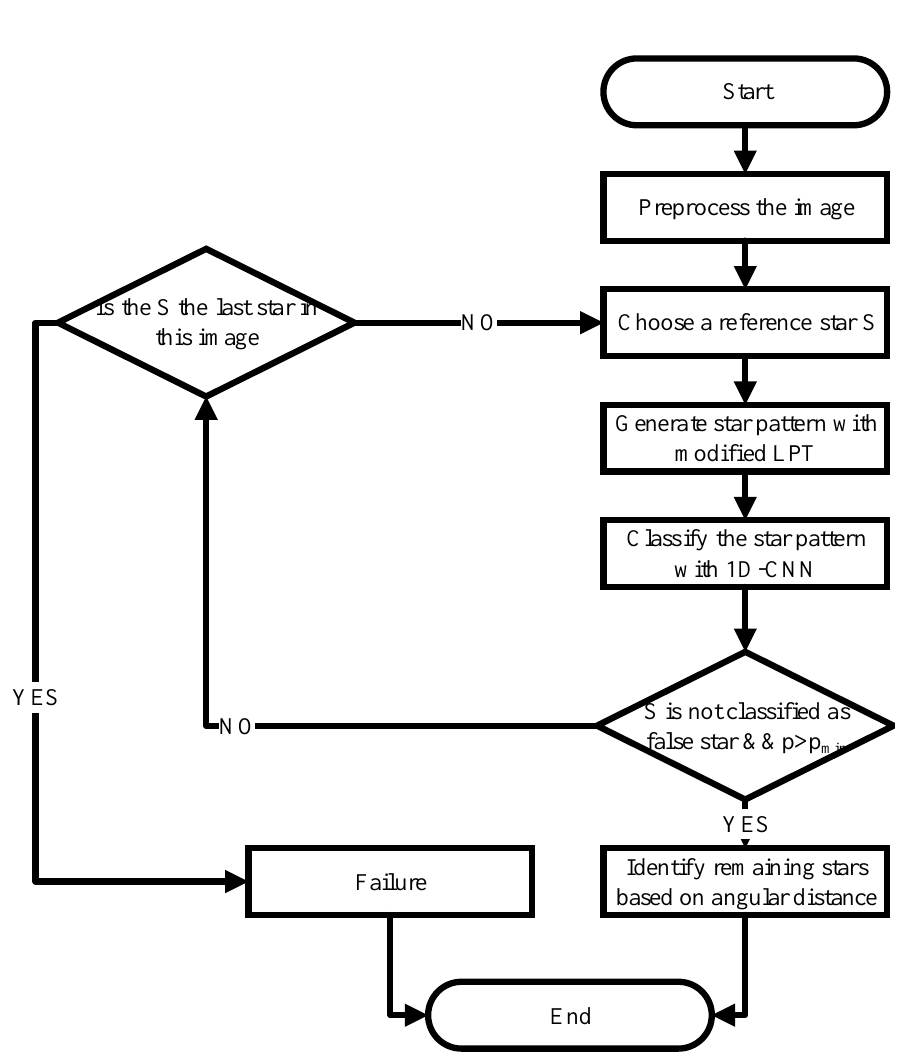
Figure 3. Flowchart of the star identification